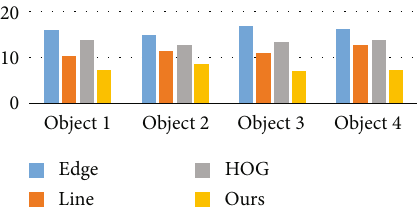
Figure 10: The performance comparison of the image features extracted in our method with several common features. The average error is measured on four objects mentioned in Section